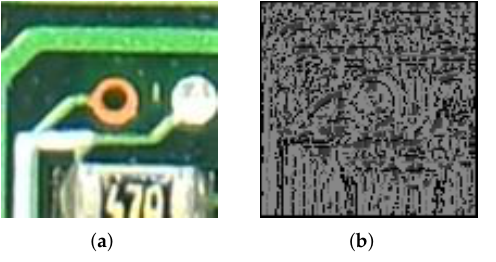
Figure 11. ( a ) A part of the original PCB image; ( b ) The output image after RLBP operators and ULBP